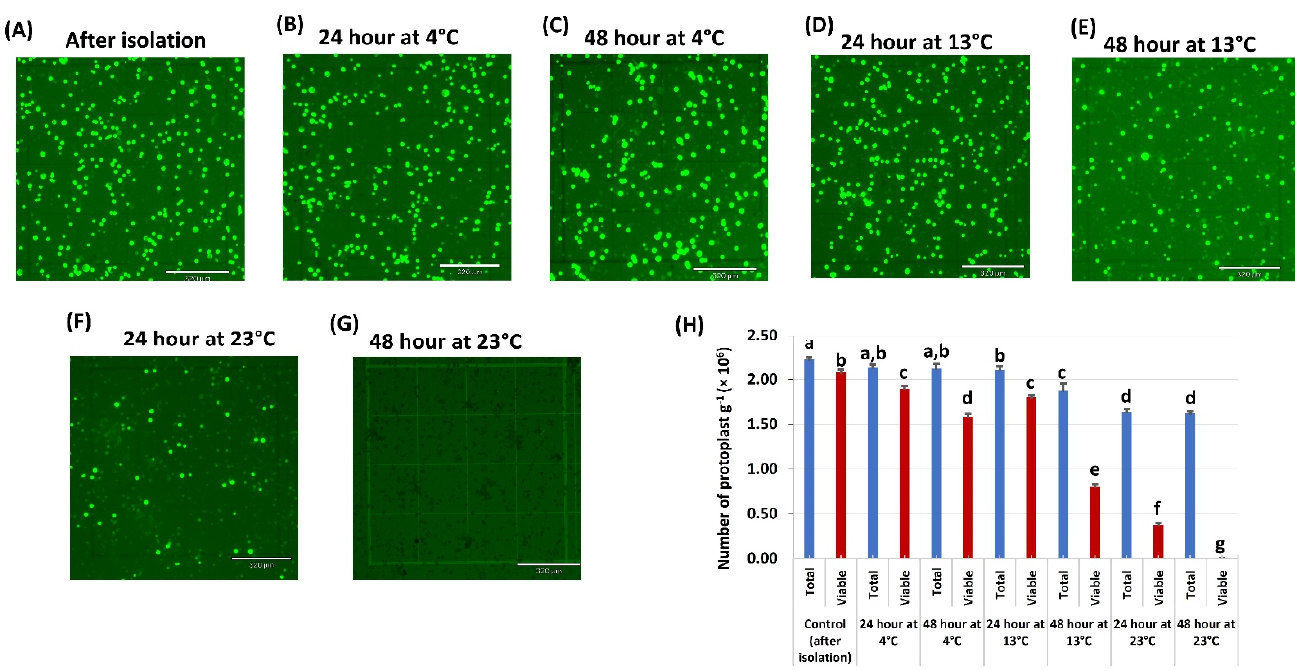
Figure 2. Protoplast viability assay under different temperatures: ( A – G ) micrograph of viable protoplasts stained with FDA under fluorescence field kept at three different temperatures, 4 °C, 13 °C, and 23 °C, for 24 h and 48 h; ( H ) the effects of temperature on protoplasts. The number of total protoplasts and viable protoplasts were counted after 24 h and 48 h cultivation. Values represent means ± SE ( n = 7). The different letters indicate significant differences at p < 0.05.